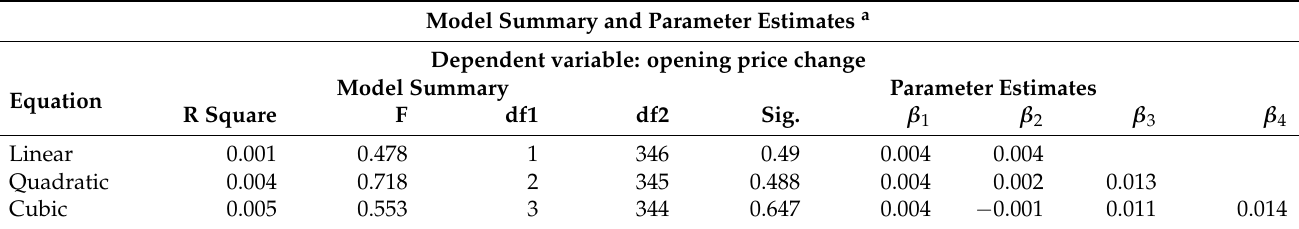
Table 5. Different regressions among opening price and sentiment score.